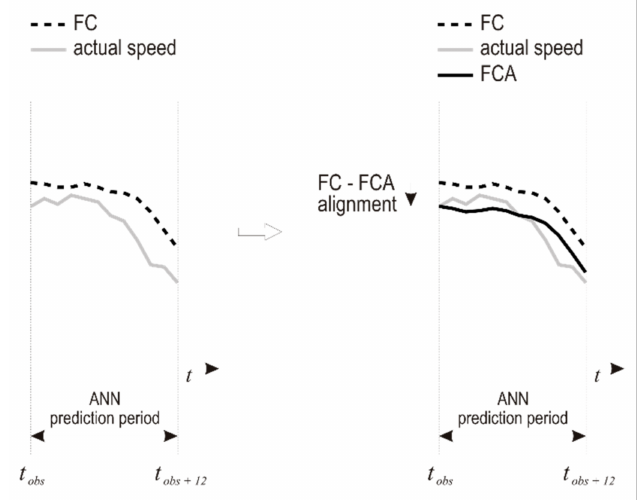
Figure 7. Alignment of corrected forecast to the last measured value.